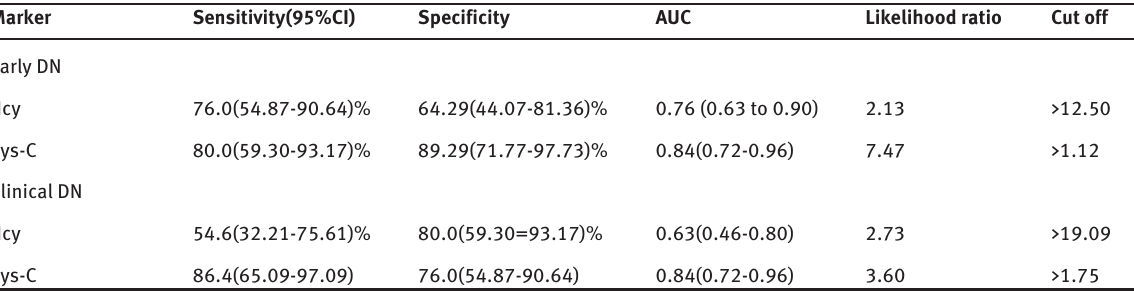
Table 3: The prediction efficacy of serum homocysteine and cystatin C as biomarker for early diabetic nephropathy and clinical stage diabetic